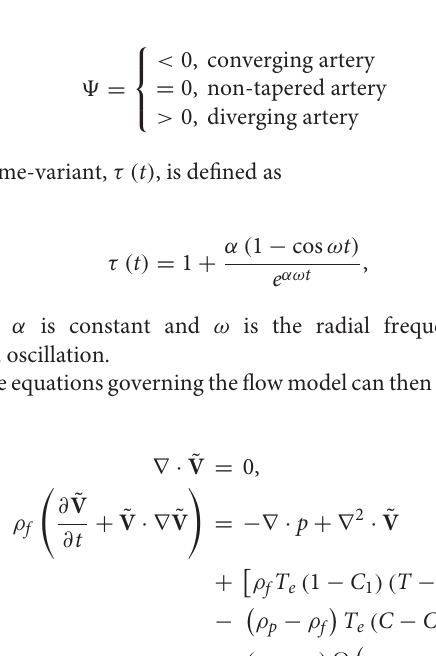
δ is the stenosis height, R 0 is the normal artery radius in the non- stenotic zone, 9 is the tapering angle, and ξ = tan 9 shows the slope of the tapered vessel